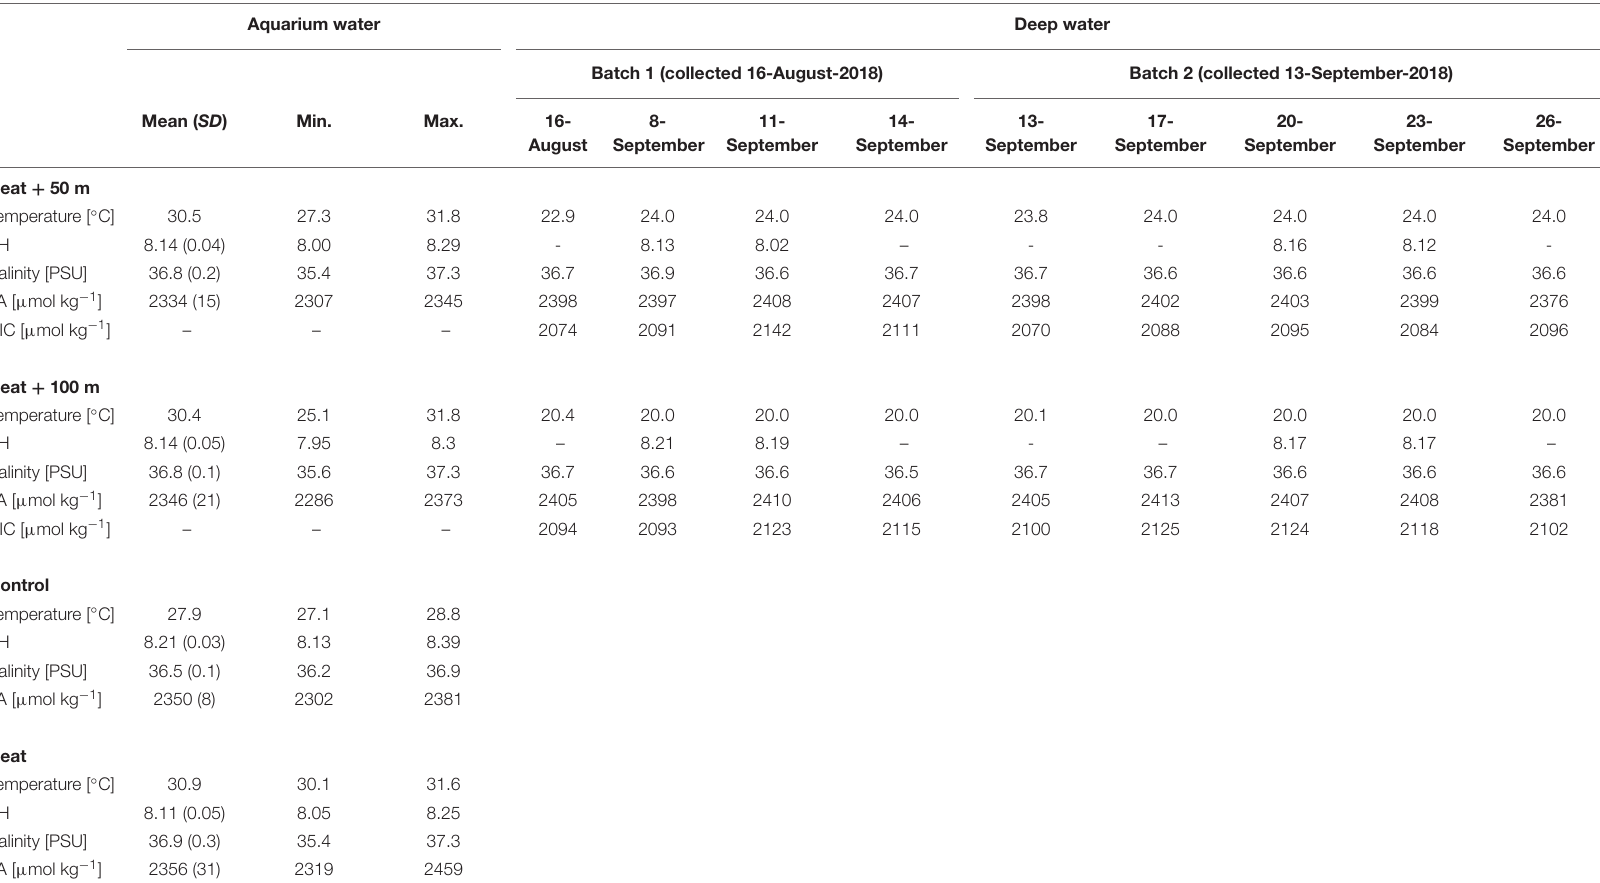
TABLE 1 | Environmental conditions of the aquarium water (experimental units) and the deep water collected at 50 and 100 m